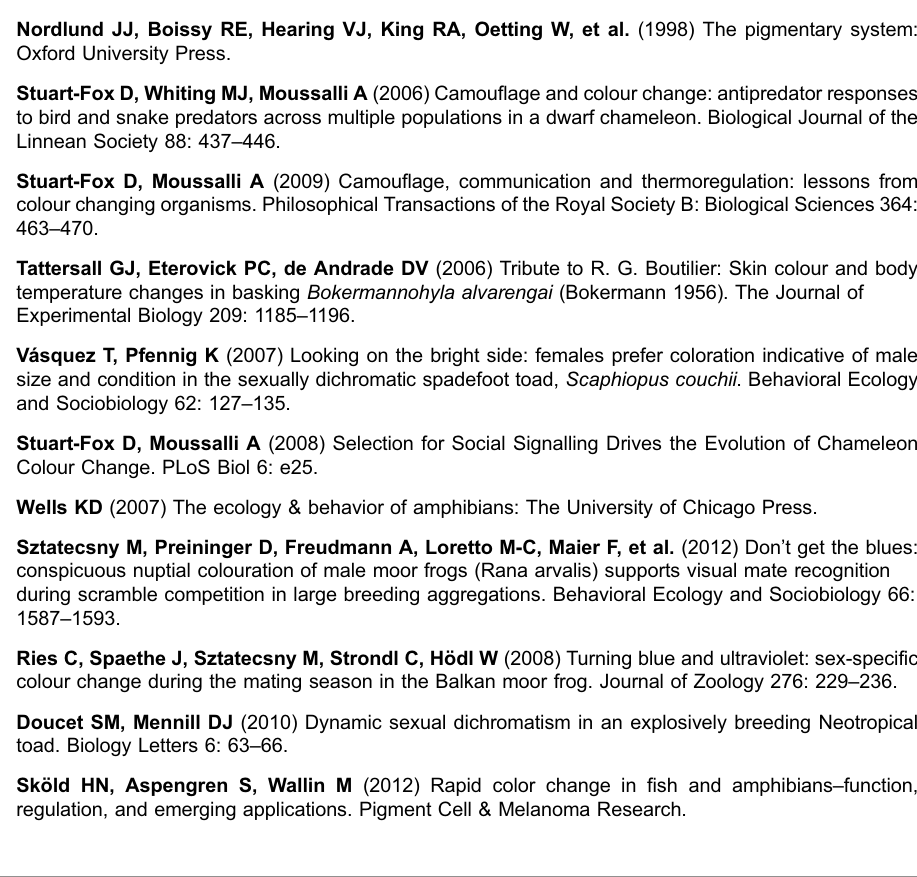
Table S1. Individual frog colour score values at for each time point and treatment. doi:10.1371/journal.pone.0114120.s001 (DOCX) Video S1. Video showing example rapid colour change in L/wilcoxii in response to epinephrine